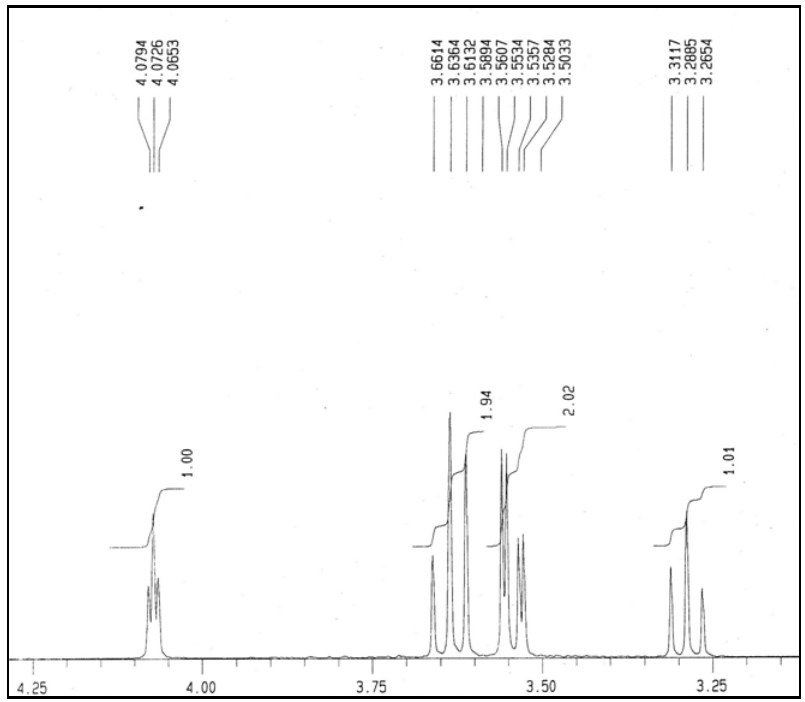
Figure 6. 1 H-NMR spectrum obtained from analysis on myo -inositol crystals isolated from red dragon fruit.